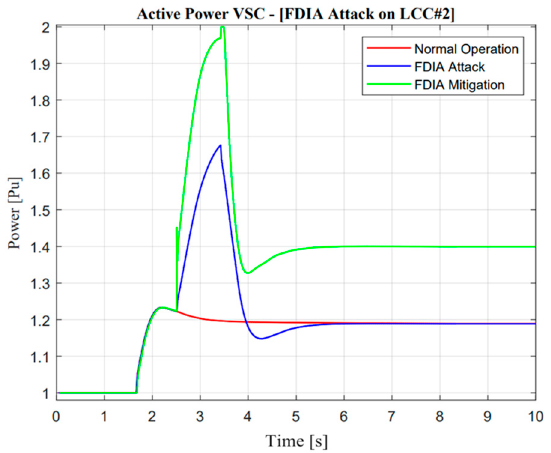
Figure 27. VSC active power response in the false data injection attack operation.